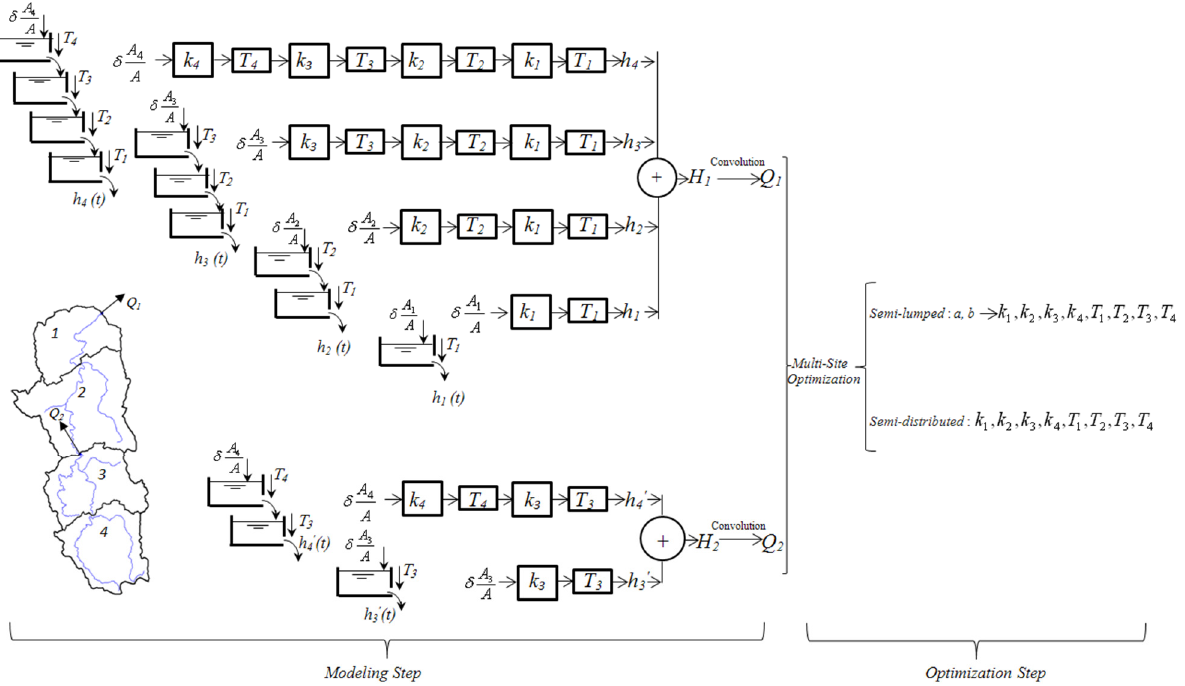
Figure 3. Schematic diagram of developed Unequal Cascade Reservoirs (UECR)